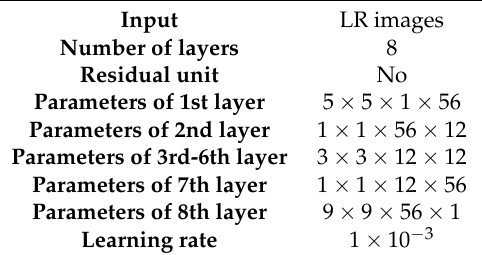
Figure 2. Network structure of FSRCNN used in this paper. Table 2. Parameters of FSRCNN used in this